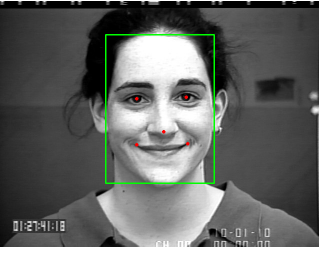
Figure 7. Detected face from the CK+ database using